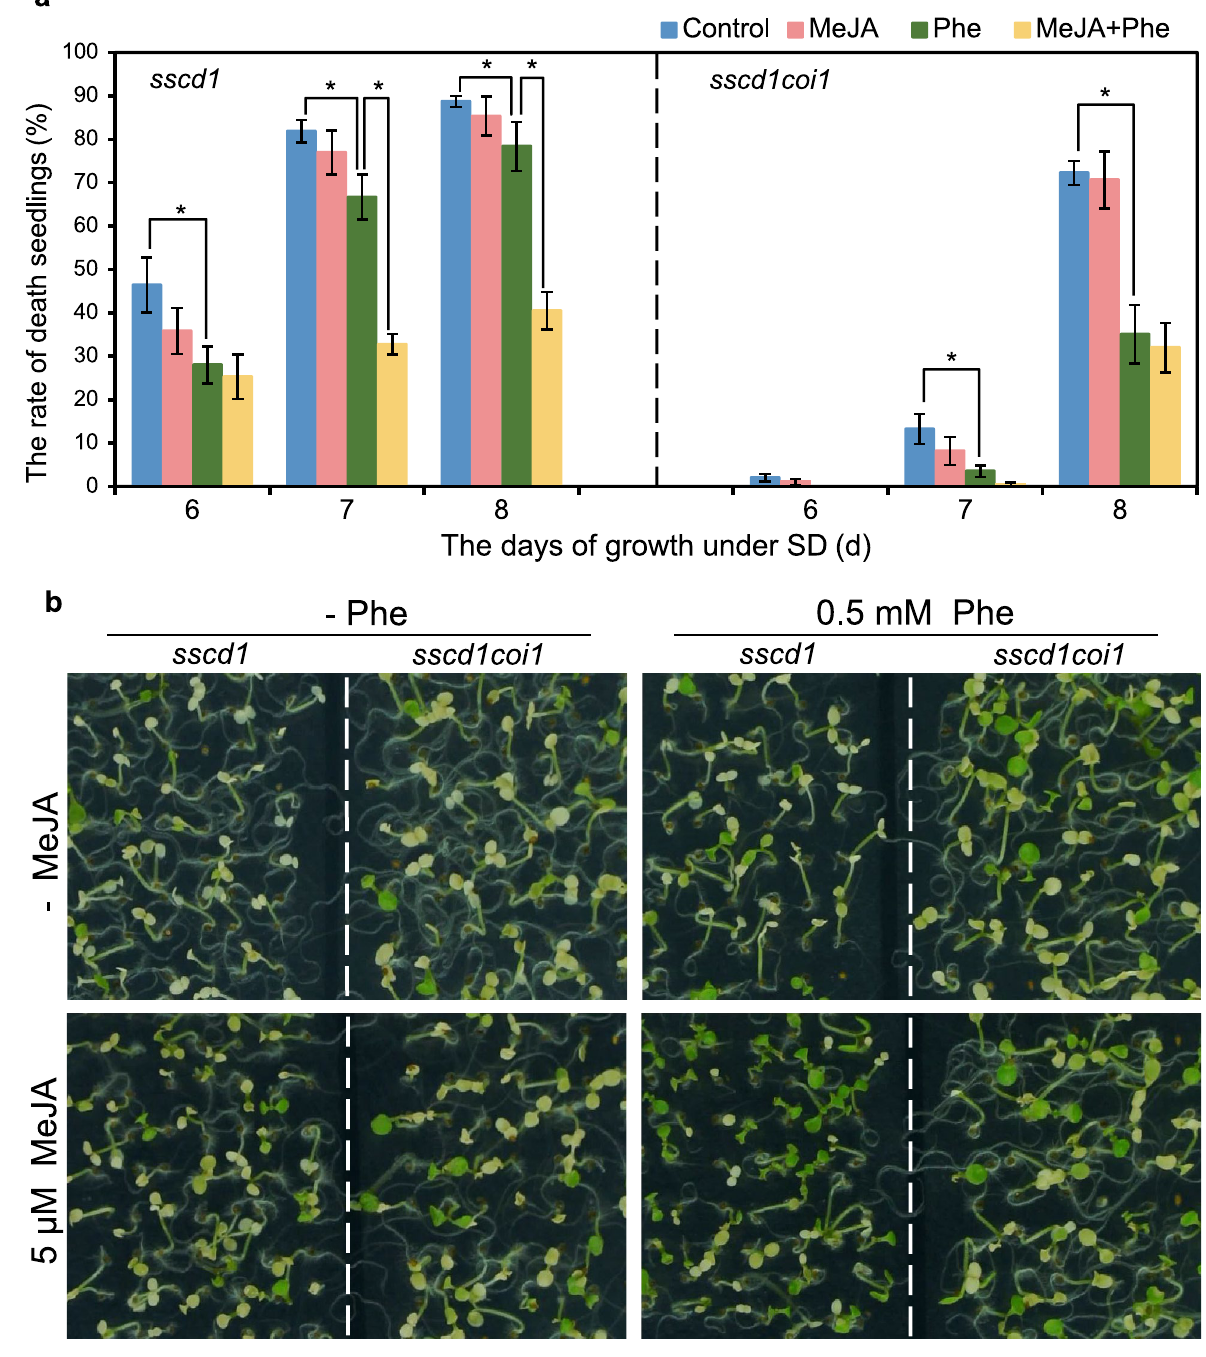
Figure 7. MeJA-increased Phe inhibition of sscd1 seedlings death was dependent on COI1 . ( a ) The death rate of sscd1 (left) and sscd1coi1 (right) seedlings which were grown in medium added without (Control) or with 5 μM MeJA or/and 0.5 mM Phe under SD for 6–8 days. Error bars represent standard deviations (n > 30). The experiment was performed in three independent biological repeats. An asterisk represents the significance of differences (two-tailed Student’s t-test) at the level of P < 0.05. ( b ) The phenotype of sscd1 and sscd1coi1 seedlings which were grown in medium added without (−) or with 0.5 mM Phe or/and 5 μM MeJA under SD for 8 days. MeJA methyl jasmonate; Phe Phenylalanine; SD short